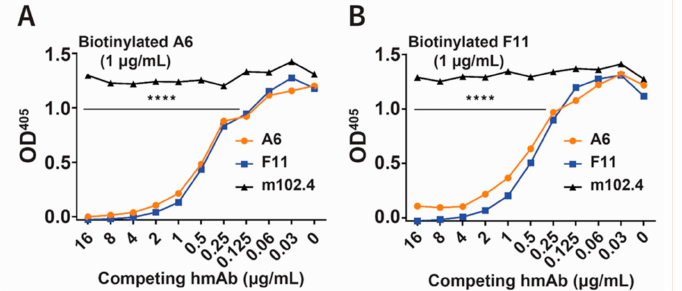
Figure 3. Competitive binding of hmAbs A6 and F11 to ABLVs G. Biotinylated hmAbs ( A ) A6 and ( B ) F11 at 1 µ g/mL were used in competition ELISAs employing increasing concentrations of unlabeled hmAbs A6 (orange circle) and F11 (blue square) in rVSV-ABLVs-G coated wells. Anti- henipavirus hmAb m102.4 (black triangle) was included as a negative control. The average value from duplicate wells is shown; **** p < 0.0001, two-way ANOVA with Tukey’s multiple comparisons of A6/F11 vs m102.4.